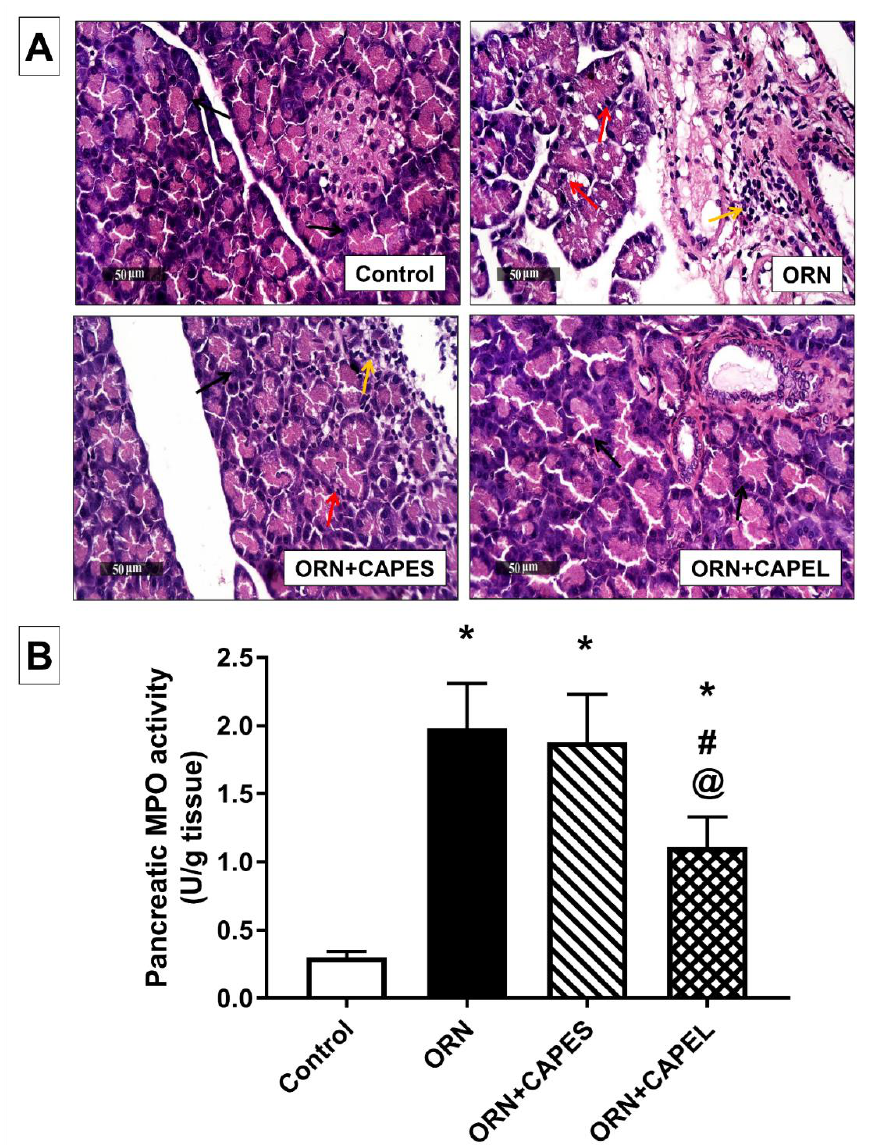
Figure 7. Effect of administering caffeic acid phenethyl ester (CAPE)-optimal liposomal